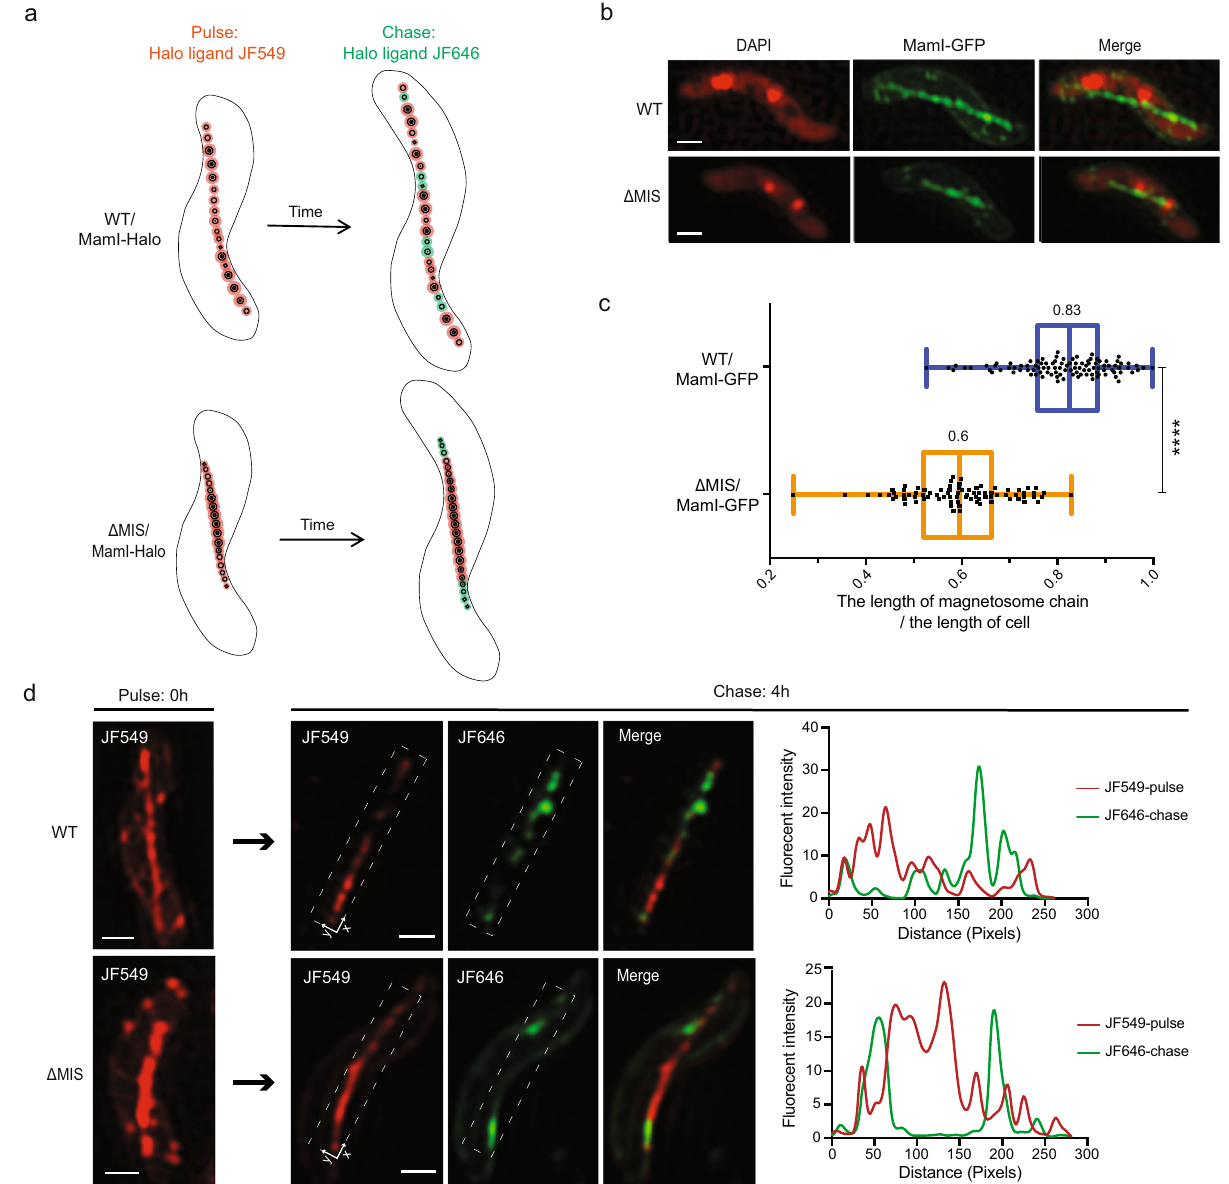
Fig.2|Pulse-chaseexperimentsthatcharacterizetheadditionofnewlyformed magnetosomes to the chain. a Model of the pulse-chase experiment shows how thenewlyformedEMsareaddedtothemagnetosomechainsinWTand Δ MIScells. b Representativemaximum-intensityprojectionof3D-SIMmicrographs(generated from 3D z-stacks) of WT and Δ MIS cells expressing MamI-GFP under standard growth conditions. MamI-GFP proteins are located in the magnetosome chain and cytoplasmicmembrane.Hereandbelow:4 ′ ,6-Diamidino-2-phenylindole(DAPI)isa fl uorescent dye that binds to DNA, and used as an indicator of AMB-1 cell contour. The DAPI staining is shown in false-color red, and MamI-GFP is shown in green. c Quanti fi cationofthelengthofmagnetosomechainversusthelengthofcellinWT